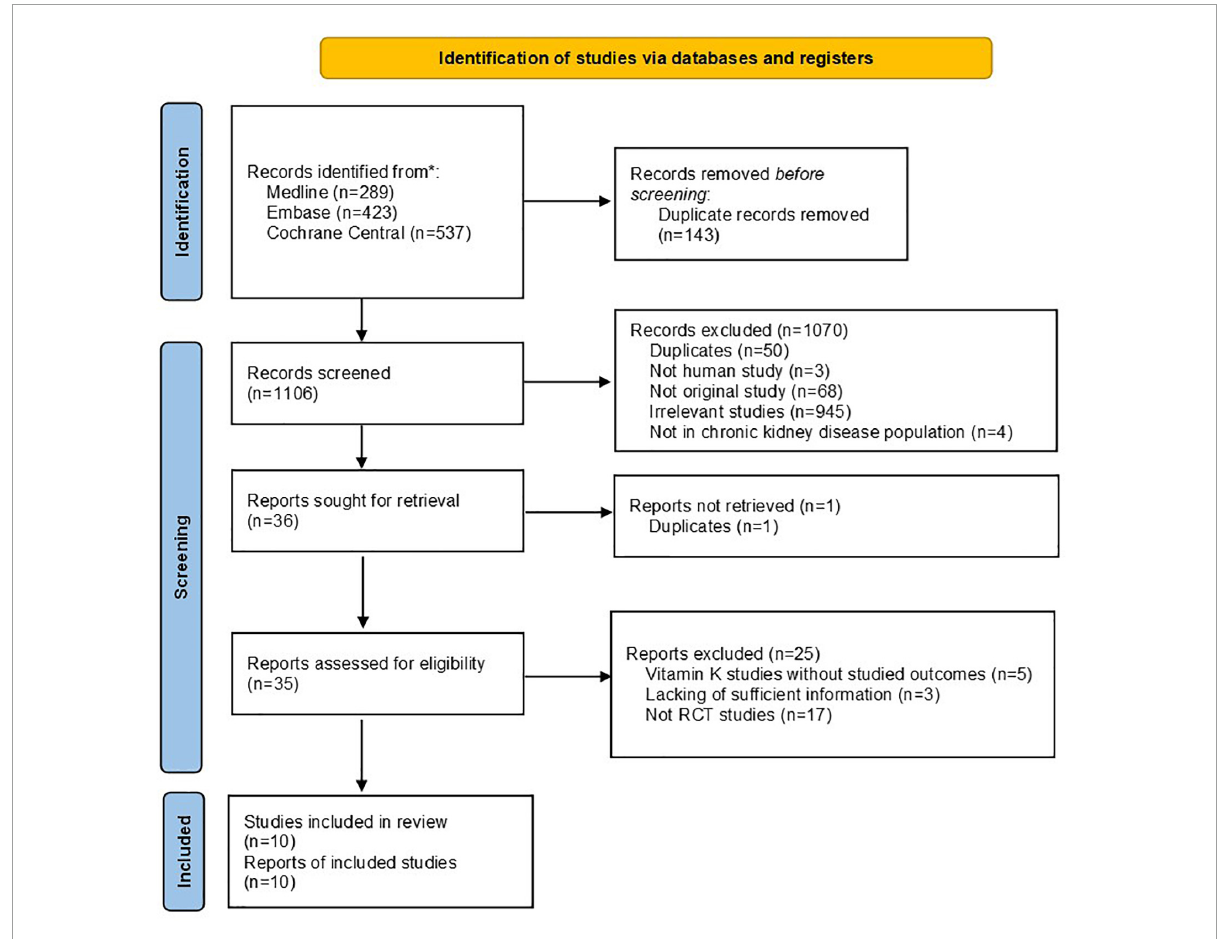
FIGURE1 PRISMA flow chart of this systematic